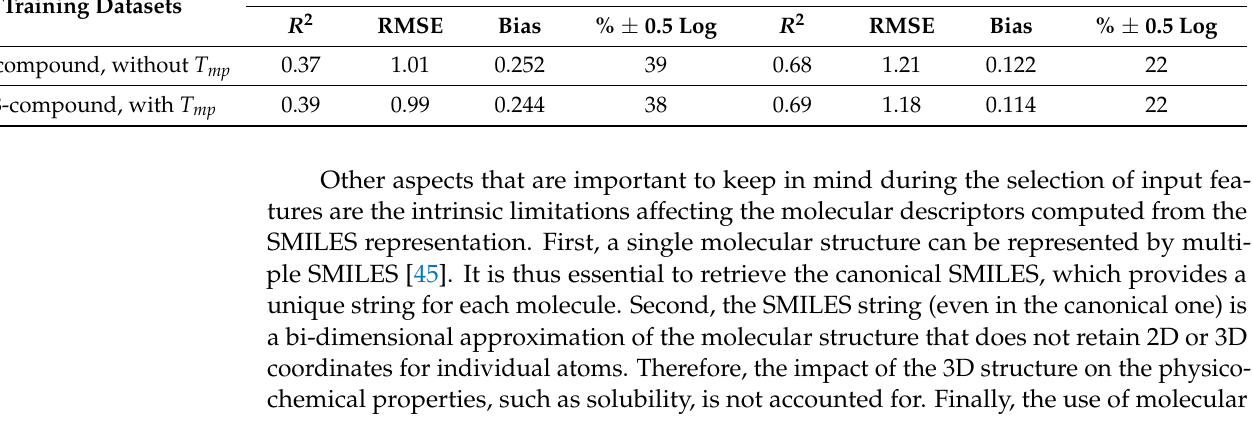
Table 9. Statistical measures of prediction performances obtained on SC-2 test sets with ANN based on 188 compounds of the training dataset. Training